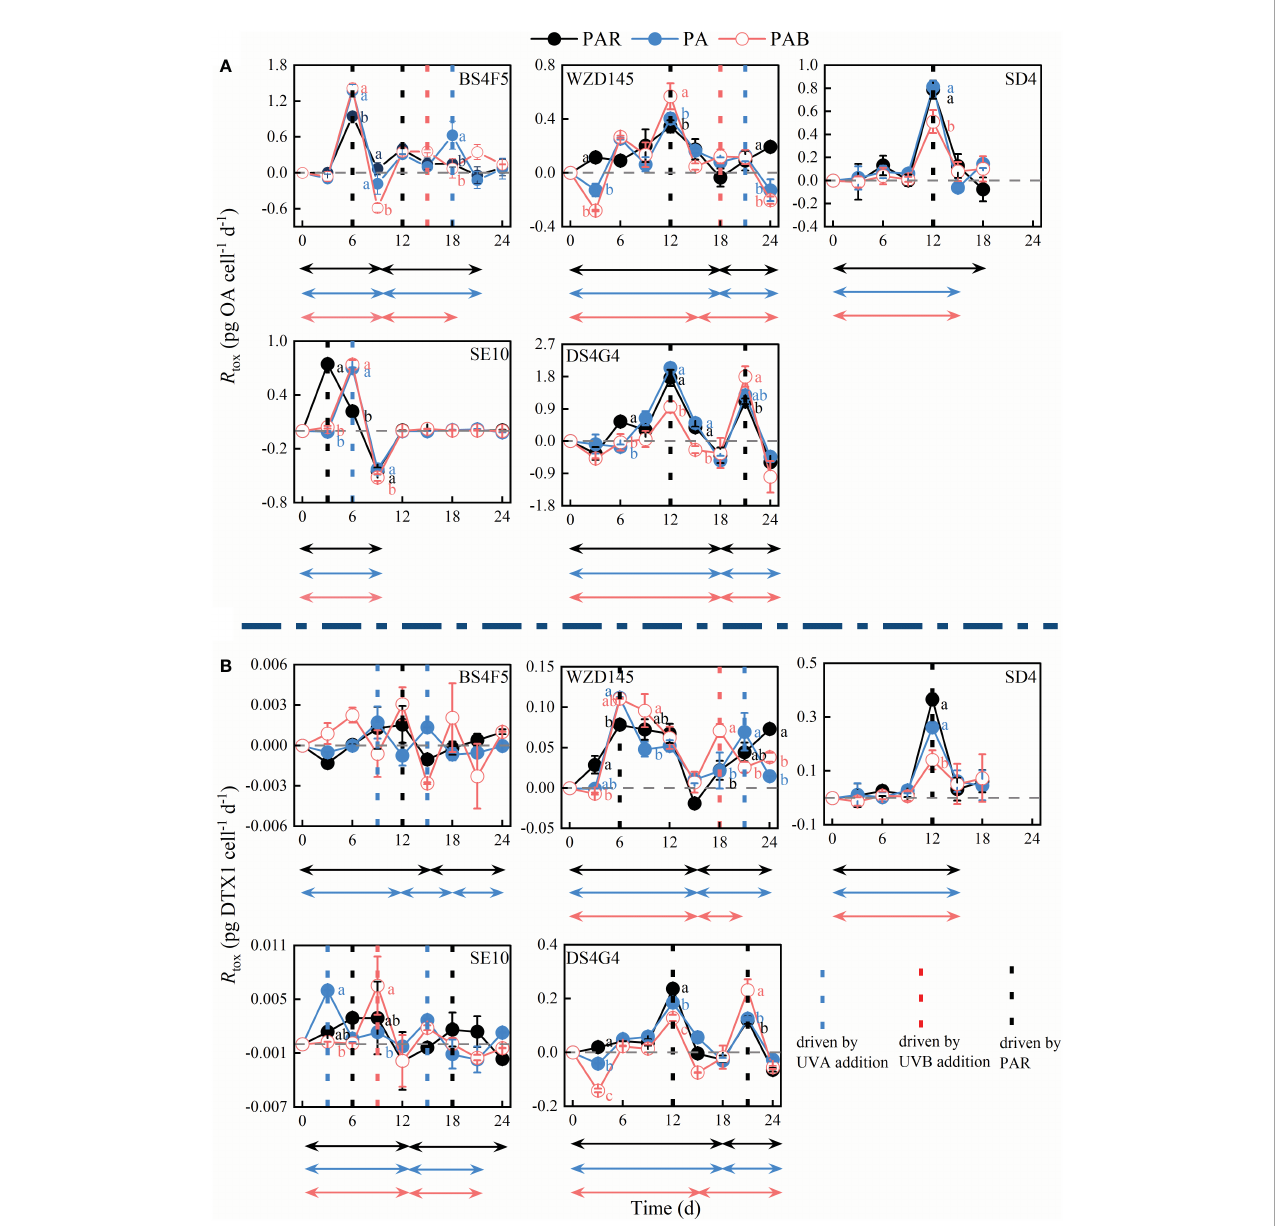
FIGURE 5 The trends in toxin production rate ( R tox ) in (A) OA and (B) DTX-1 of the fi vestrains of P. lima complex and P. caipirignum (strain SE10) over time under PAR, PA, and PAB treatments. LL, ML, and HL before the morphotypes represent their DTX-1 production capacities: 0.001-0.01, 0.01-0.1, and 0.1-1 pg cell -1 d -1 , respectively. Regular peaks are shown in the time series. A complete ascent and descent process of R tox is termed a period and highlighted using a two-way arrow. The colour of the arrows represented different light treatments. Statistically signi fi cant differences ( p < 0.05) between the light treatments at the same time point are labelled using different letters,